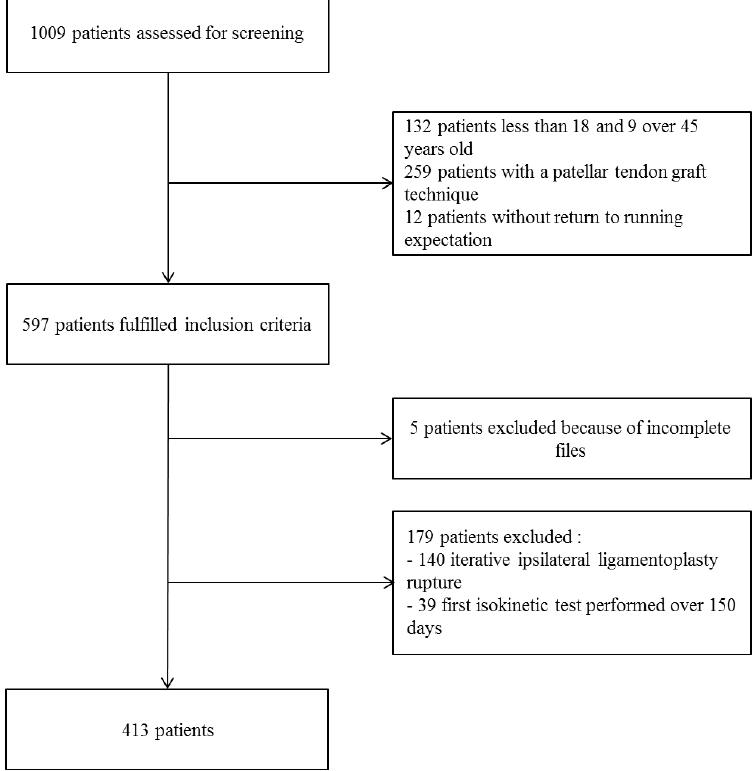
Figure 1. Flowchart of the included participants.